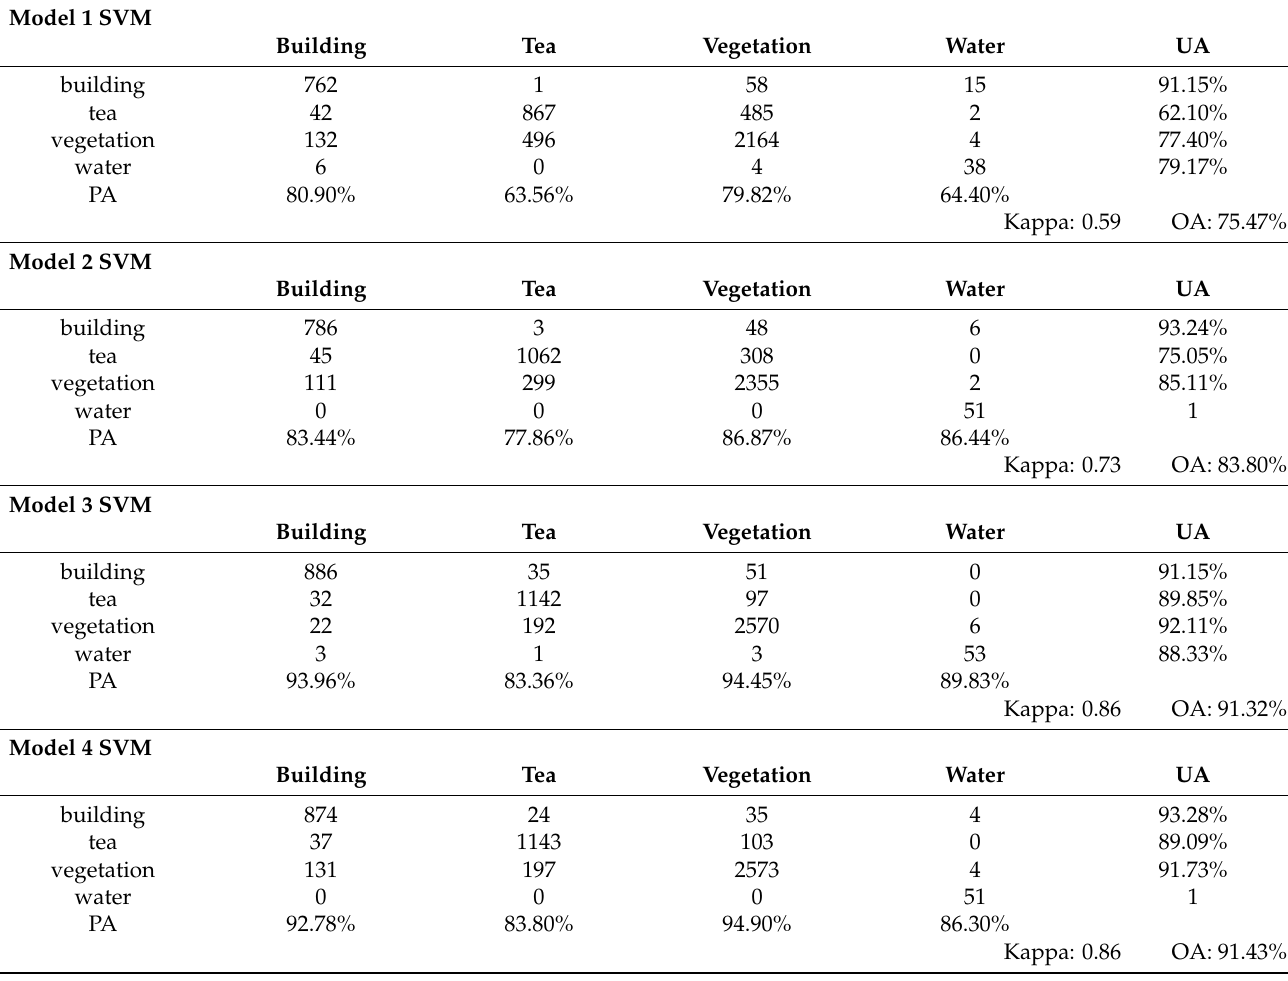
Table 4. Confusion matrices of Models 1, 2, 3, and 4 obtained using SVM based on the validation samples.